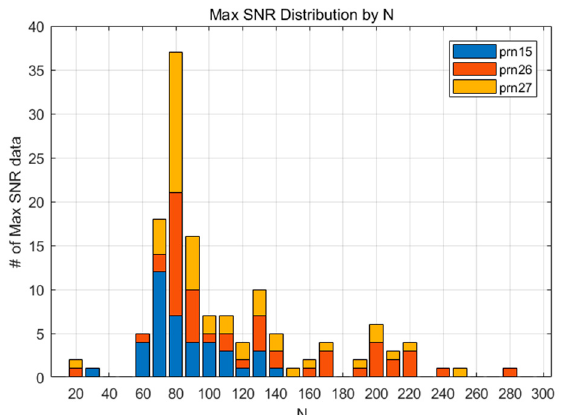
Figure 5. The maximum SNR distribution according to various values of N (MND) .